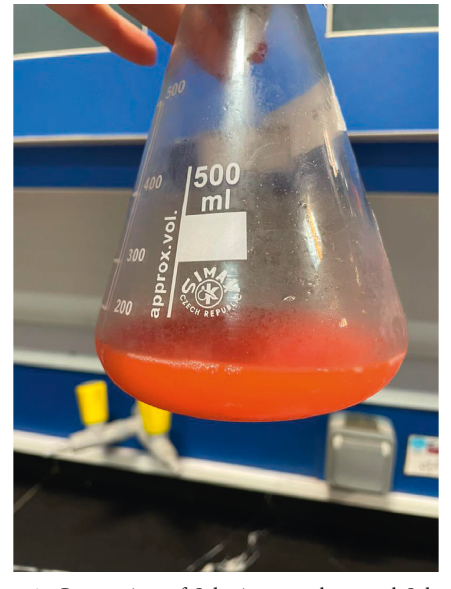
Figure 2: Conversion of Selenium to elemental